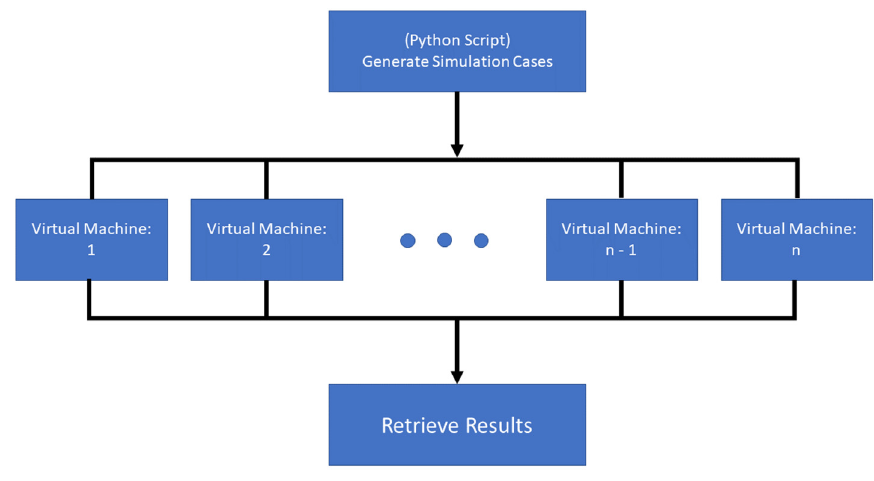
Figure 7. Cloud simulation workflow.